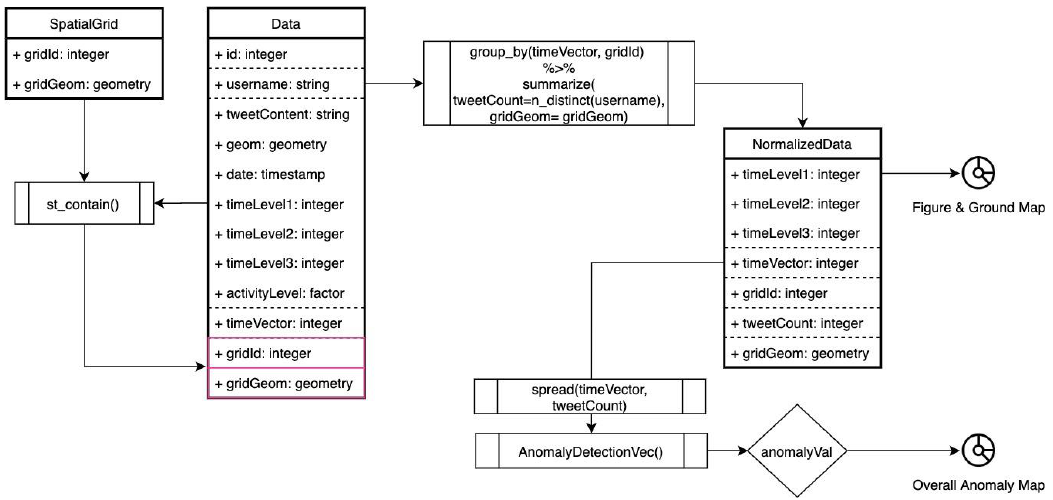
Figure 5. Anomaly Detection Stage 2.